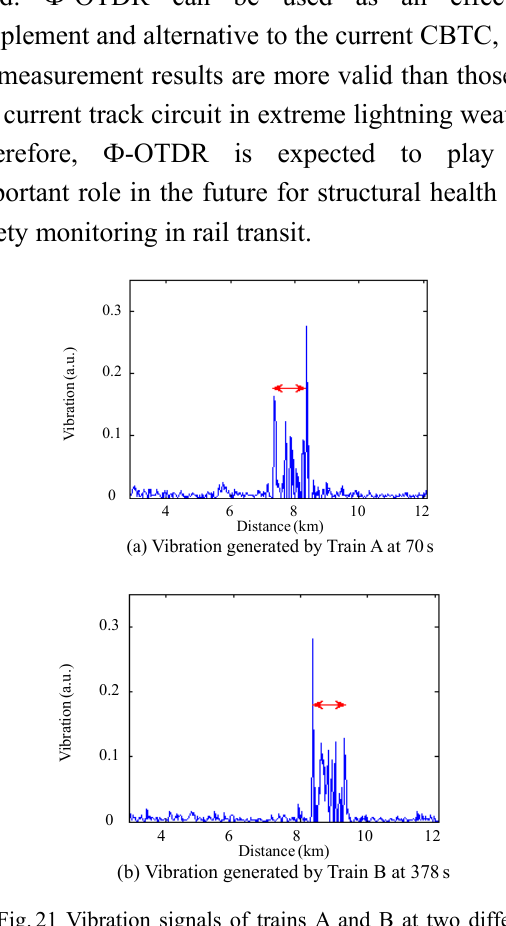
Fig. 21 Vibration signals of trains A and B at two different time